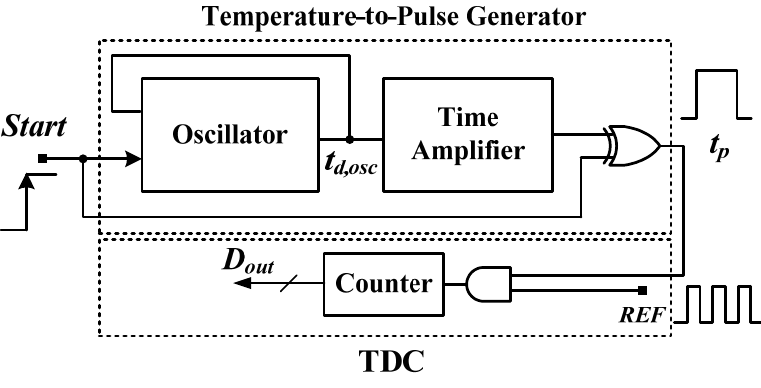
Figure 3. Block diagram of a smart temperature sensor with a reference clock adapted from